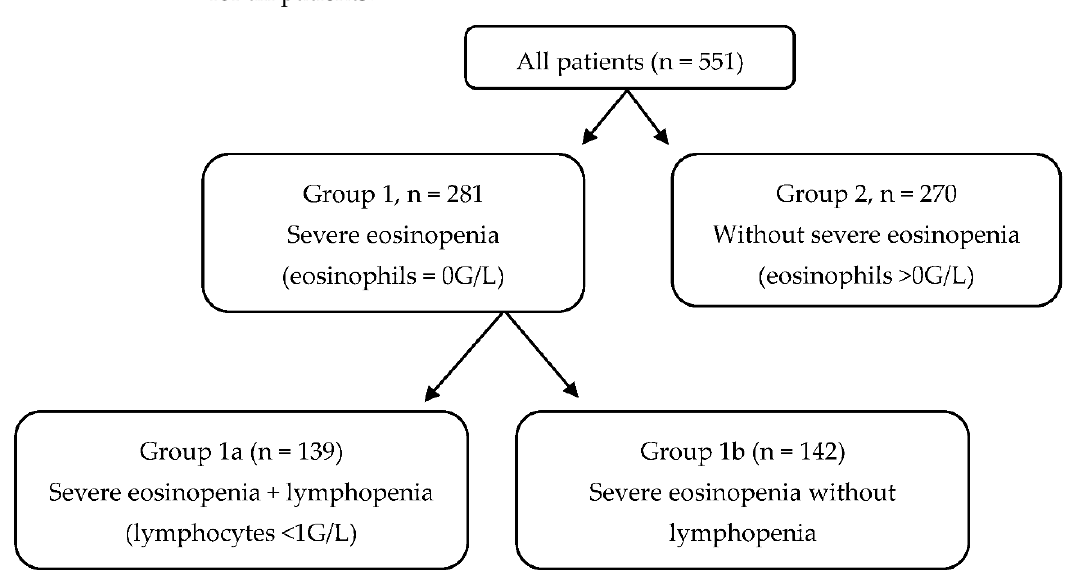
Figure 1. Flow Chart of the study cohort.